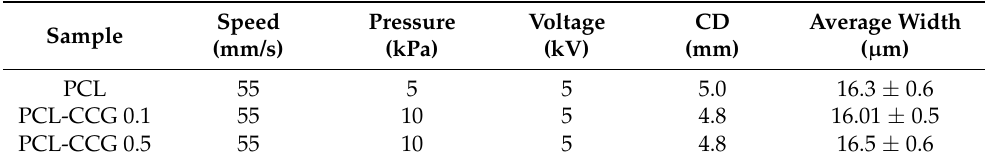
Table 1. Printing parameters for scaffolds.